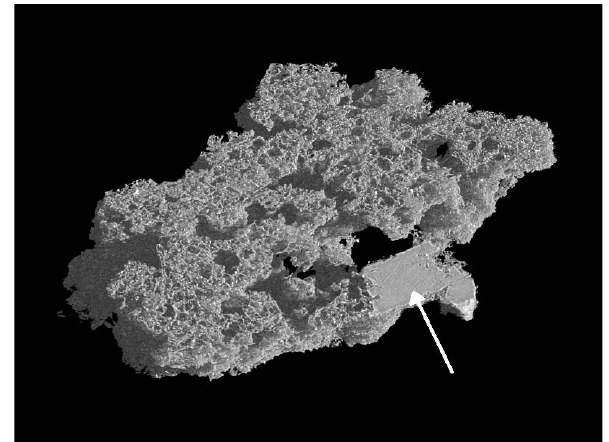
Fig. 1. Three-dimensional X-ray microtomographic rendering of natural sample EFJ080510b; a plagioclase crystal (indicated by the arrow), which is rare in products of this eruption that had less than 2% crystallinity (Sigmundsson et al., 2010), can clearly be seen in the sample. The long dimension of this sample is